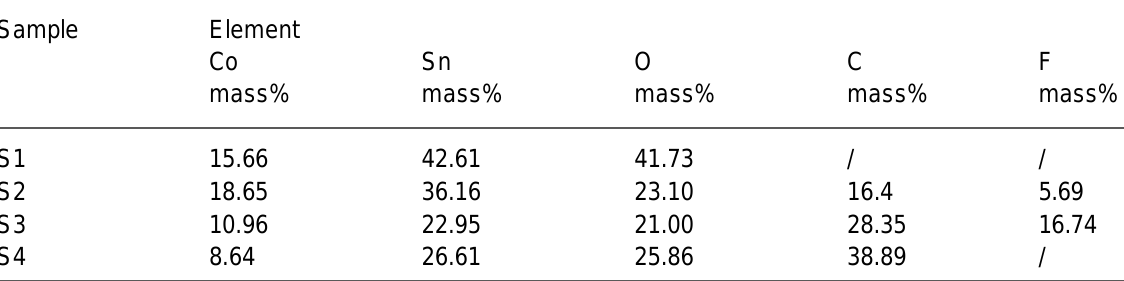
Table 1. EDS results for the elemental composition of the Co-Sn nanoparticles. Sample